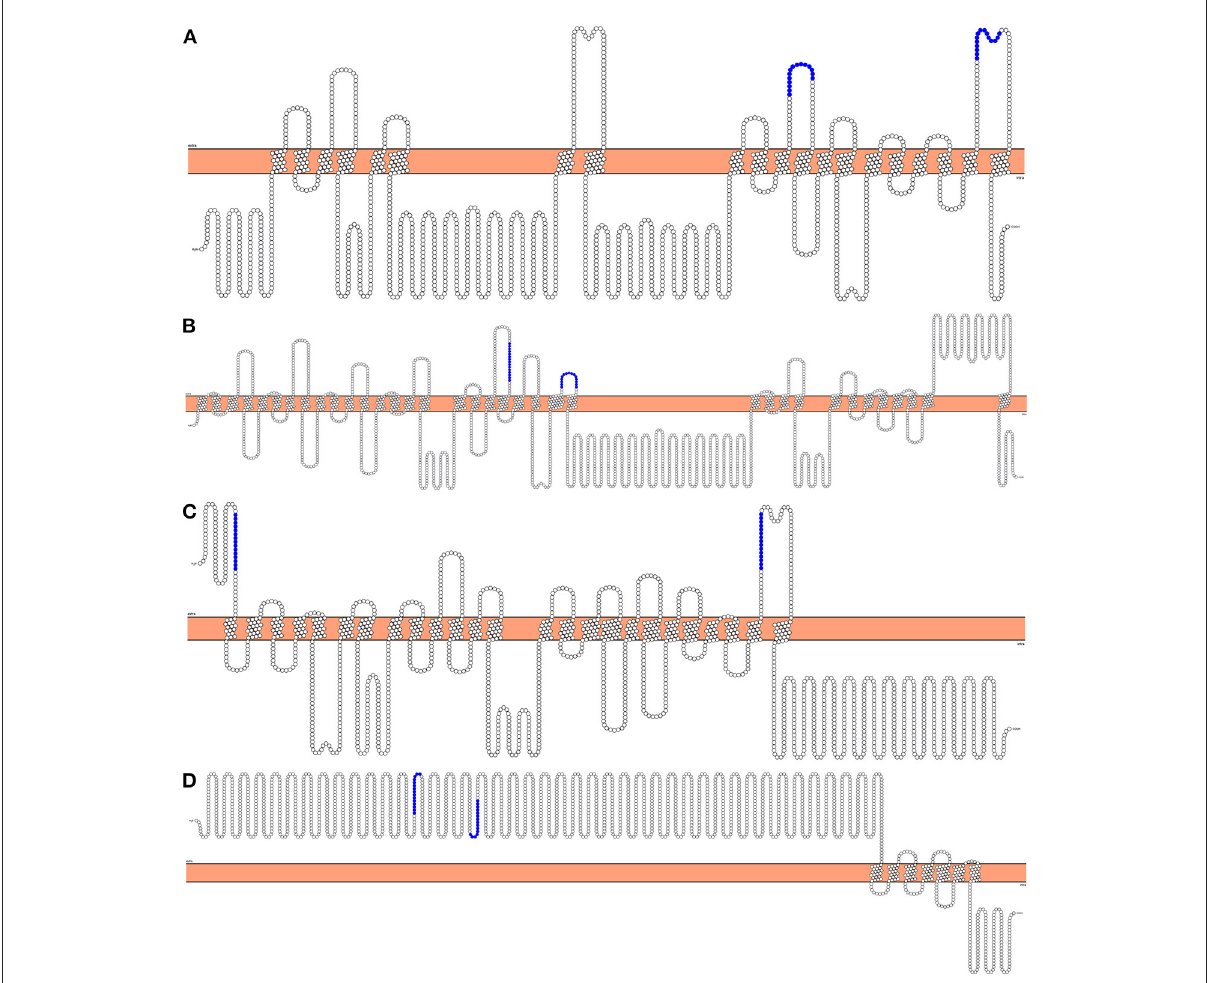
FIGURE2 2D representation of the topology of predicted vaccination targets using Phobius predictions. The horizontal bar in the middle represents the membrane, above it is the extracellular domain, and below is the intracellular domain. Highlighted are the Cd4 + Th epitopes chosen to be incorporated in future vaccination assays. (A) “ AgB13X_g094_t05 ” as the best expressed protein transcript for ATtype. (B) “ AgR007_g063_t01 ” as the best expressed transcript for APiezo. (C) “ AgR007_g282_t05 ” as the best expressed protein transcript for ALtype. (D) “ AgB13X_g096_t06 ” as the best expressed protein transcript for